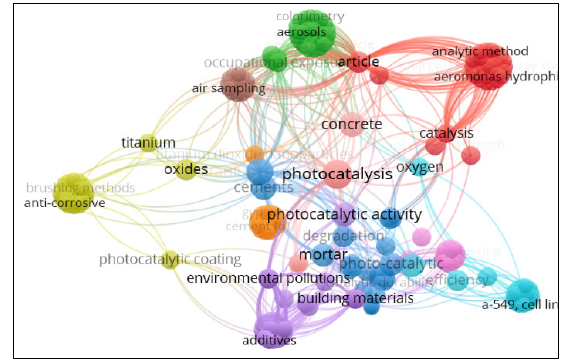
Fig. 2b. Map of the analysis of the words “Concrete”, “Photocatalytic” and “Environmental” with the highest in- teraction